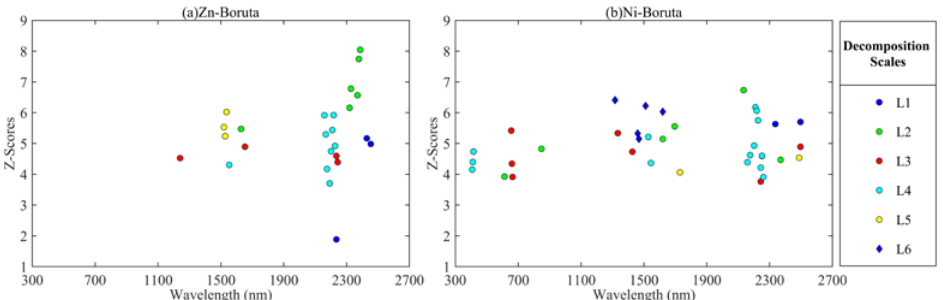
Figure 6. The position of feature bands for Zn and Ni based on the Boruta algorithm.